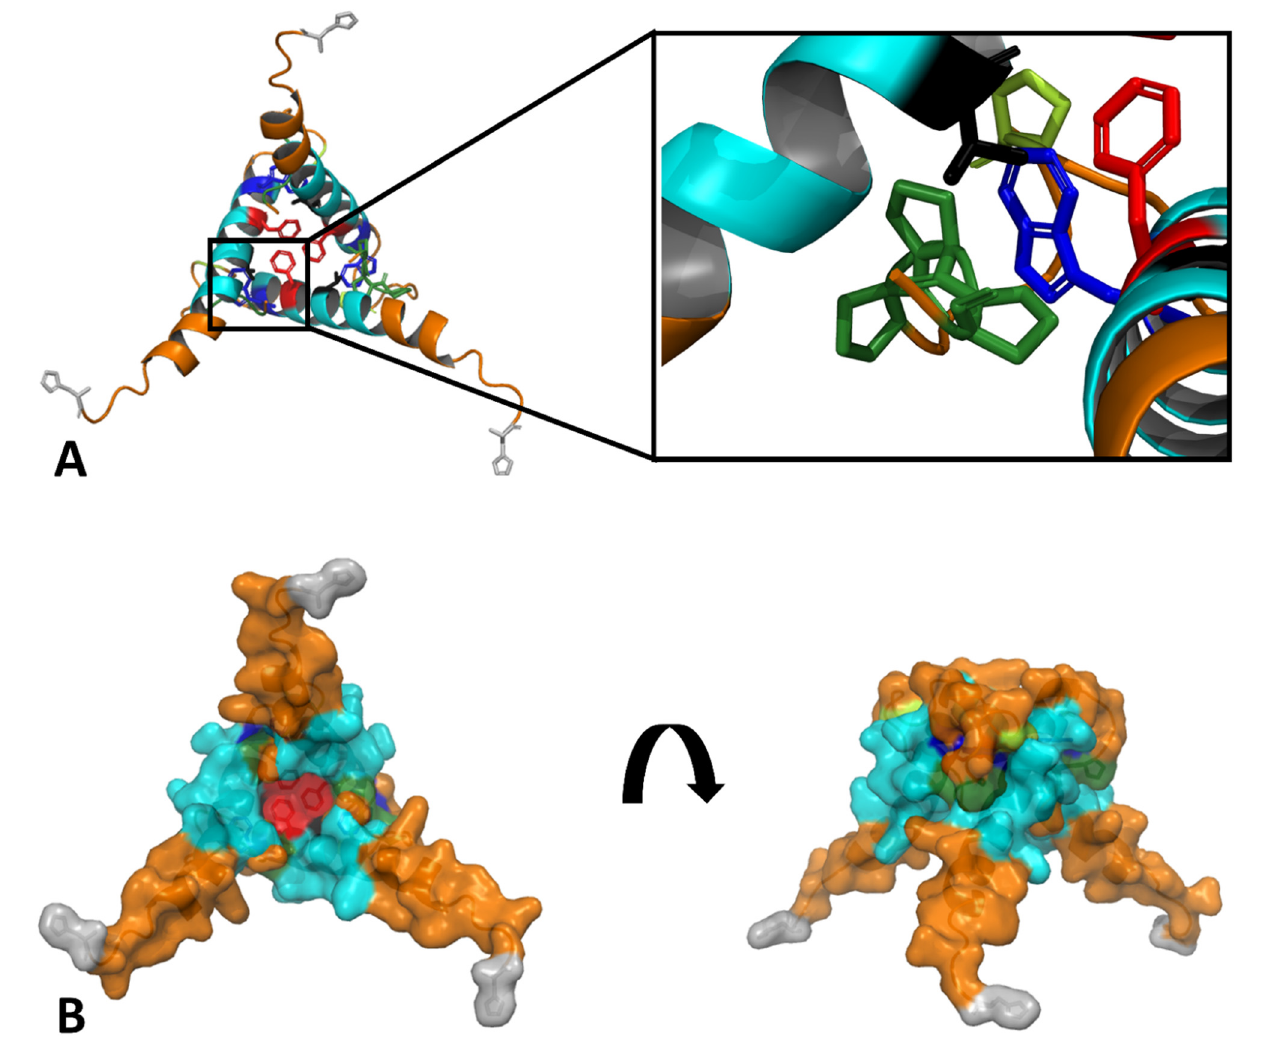
Figure 11. Structural hypothesis on the self-assembly of exendin-4 visualizing key interactions. The structural hypothesis introduced in Figure 2E was recolored, the hydrophobic moiety is shown in magnification ( A ). ( B ) shows the hypothesis in surface representation in different orientations for visualization of key interactions. N-termini are indicated in grey, the helical interface segment (AA13–26) is represented in cyan, Pro31 in light green and Pro 36–38 in dark green, respectively. Trp25 is shown in blue, Phe22 in red and Val19 in black colors. All other amino acids are shown in orange.